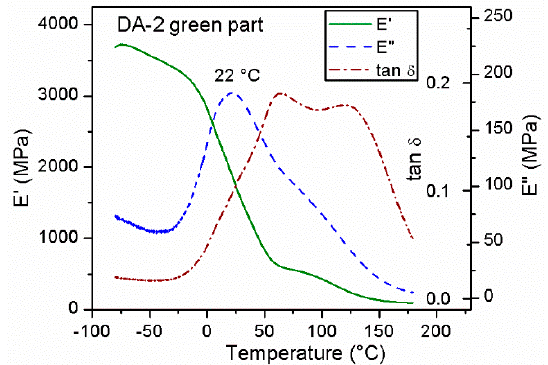
Figure 4. DMA thermogram of a DA-2 green part.